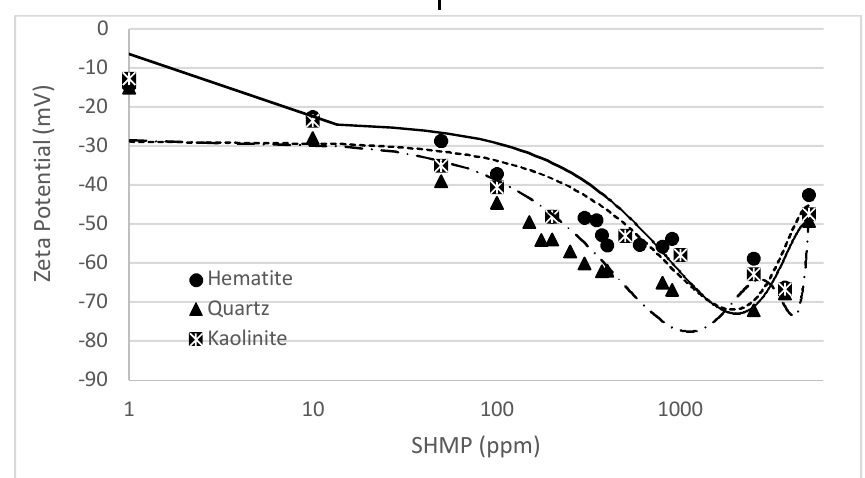
Fig. 6: Effect of SHMP on The ZP of Hematite, Quartz and Kaolinite at 10.5 pH